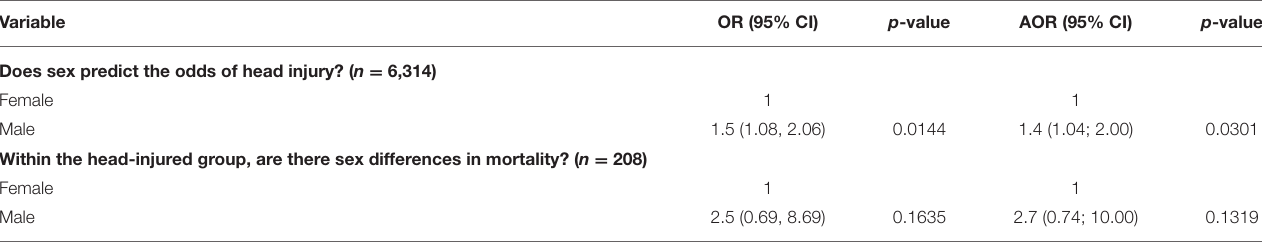
TABLE 4 | Sex-predicted outcomes for patients in the Kintampo Registry.